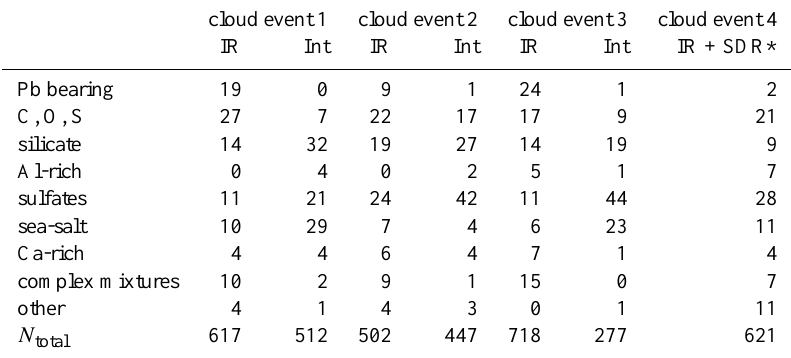
Table 3. Relative particle group number abundance [%] of the different particle groups of ice residuals (IR) and interstitial samples (Int) for four cloud events ( d P ≥ 0 . 7µm).